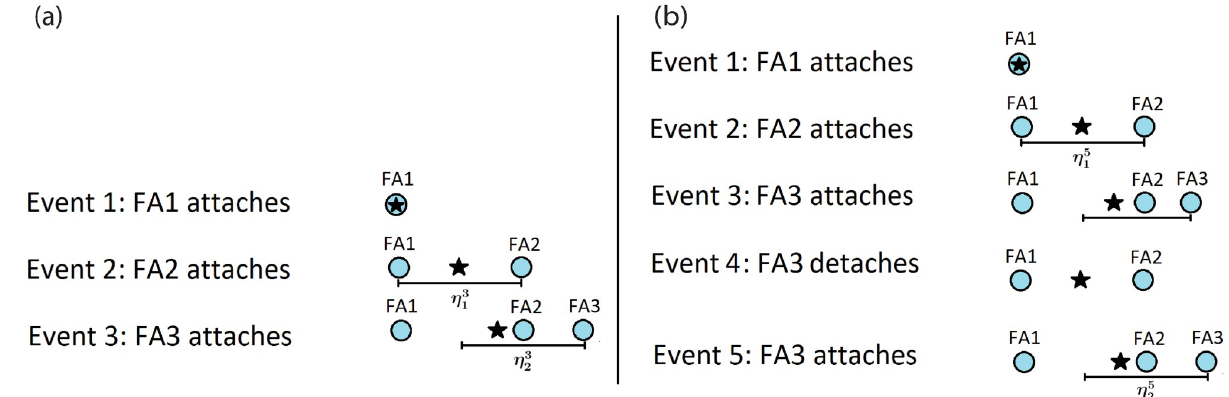
Fig 3. Visualization of sequential attachment configuration with two different histories. For simplicity, the visualization is in one dimension. In panel (a), the first FA (FA1) attaches, denoted by the blue circle. The location of the centroid c 1 is denoted by the star. The next FA (FA2) attaches at distance η 1 from the centroid. The new centroid is calculated, c 2 . The third FA (FA3) attaches at a distance η 2 from the centroid. A new centroid is calculated, c 3 . Panel (b) shows a different history that still has the same sequential configuration as panel (a) because they share a common sequential creation story. The sequential creation story for event 5 has the sequential attachments happening at Event 2 and Event 5.